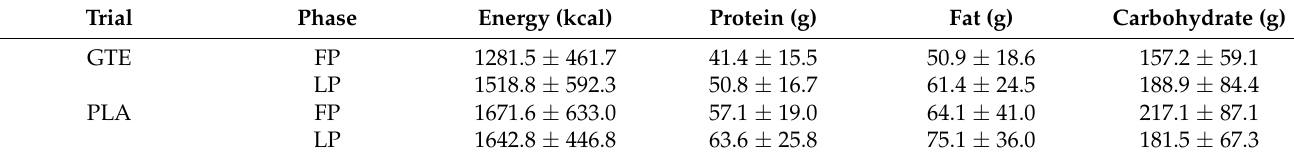
Table 4. Energy and macronutrient intake of the